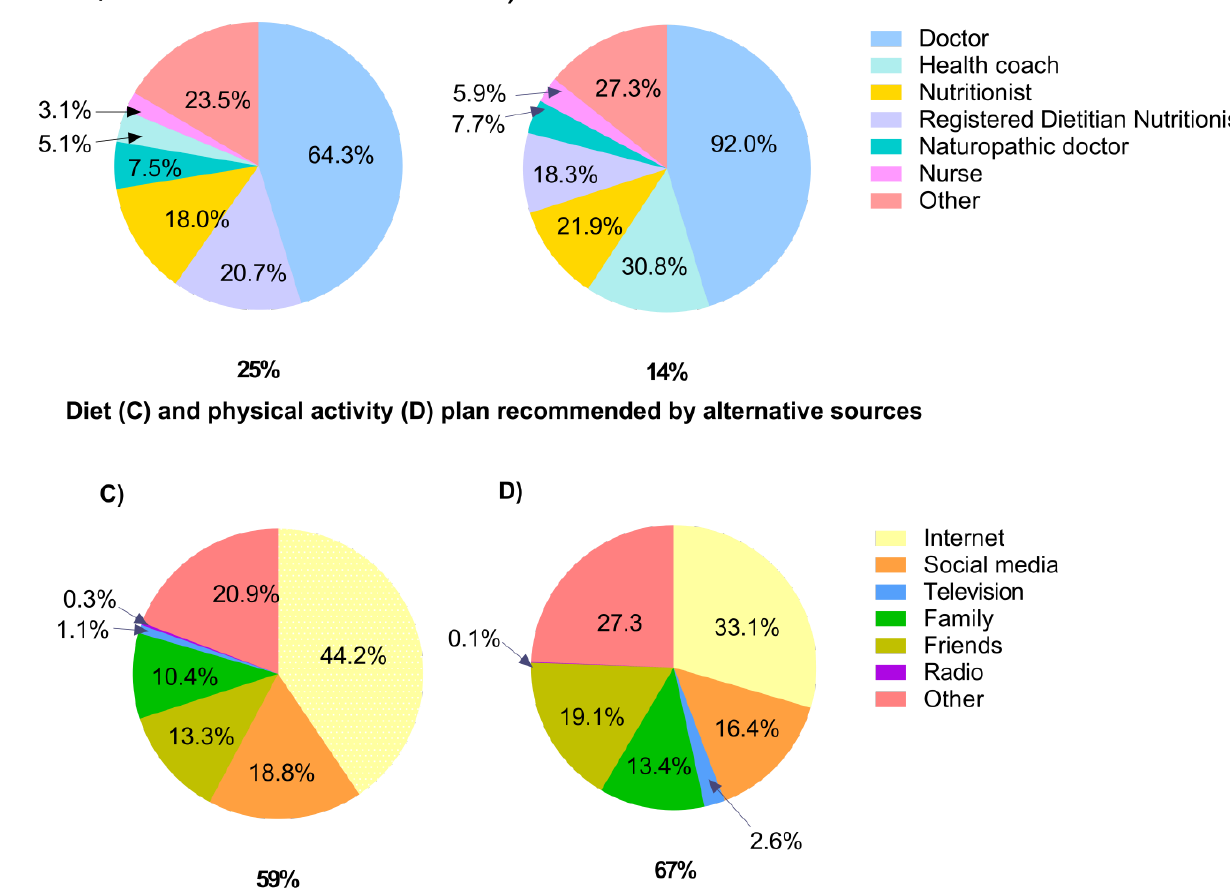
Figure 1. Diet and physical activity plans recommended by qualified health professionals ( A , B ). Diet and physical activity plans recommended by alternative information sources ( C , D ). Percentages beneath pie charts are expressed as a proportion of the total study sample (n = 1167). All other percentages (within pie charts) are expressed as a proportion of their corresponding category (e.g., of the 14% of women who sourced physical activity recommendations from a health professional, 92% of these women received this information from their doctors). Percentages do not add up to 100% where survey respondents could provide ≥ 1 answer or where there were missing values.